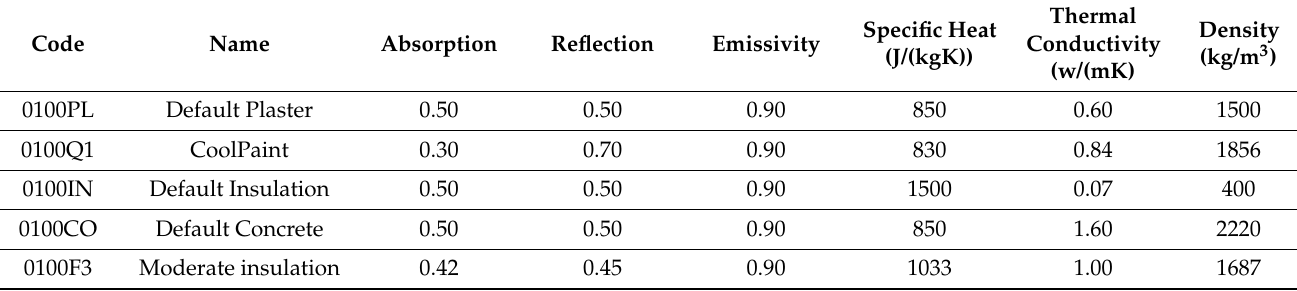
Table 4. The building materials’ properties are used for all typologies.